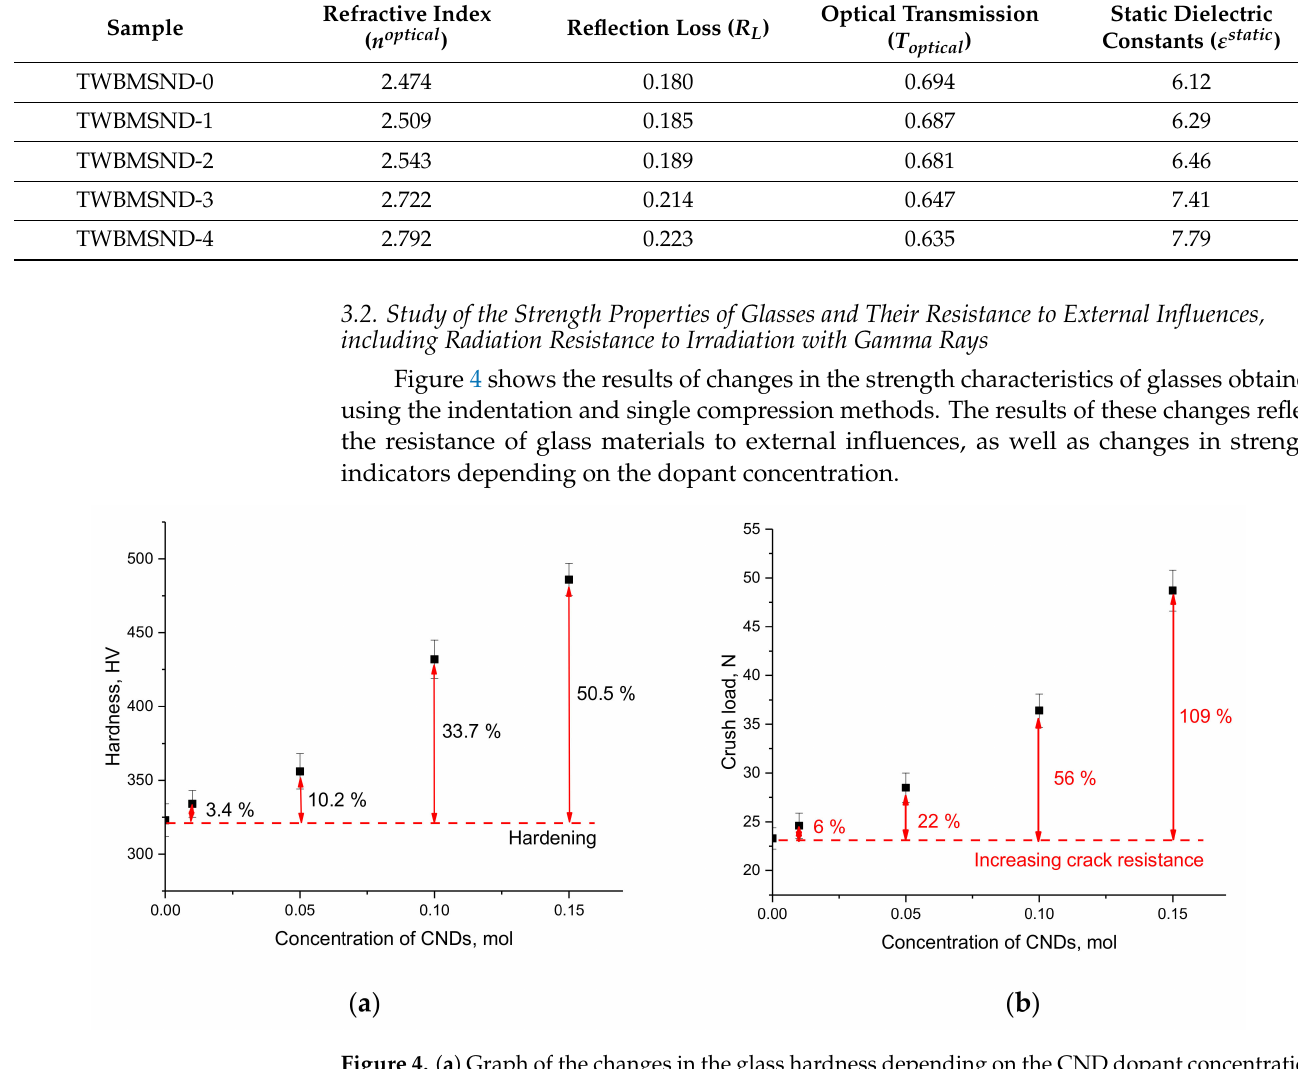
Figure 4. ( a ) Graph of the changes in the glass hardness depending on the CND dopant concentration; ( b ) Graph of the change in the crack resistance value at a single compression depending on the CND dopant